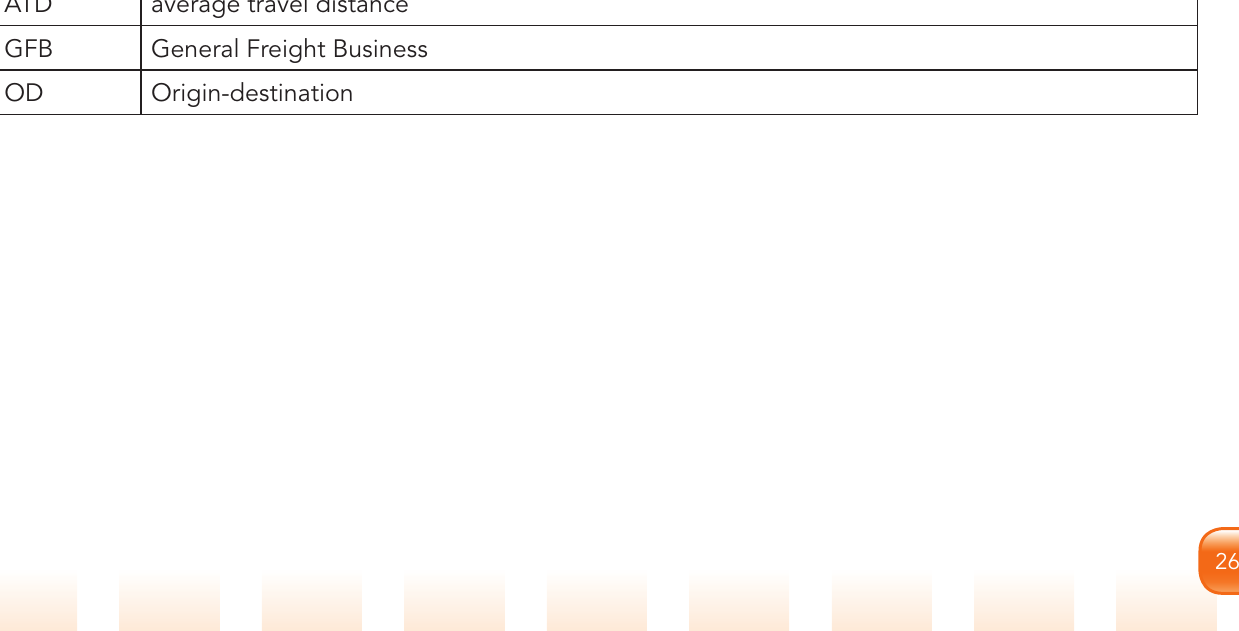
AsgiSA Accelerated and Shared Growth Initiative for South Africa